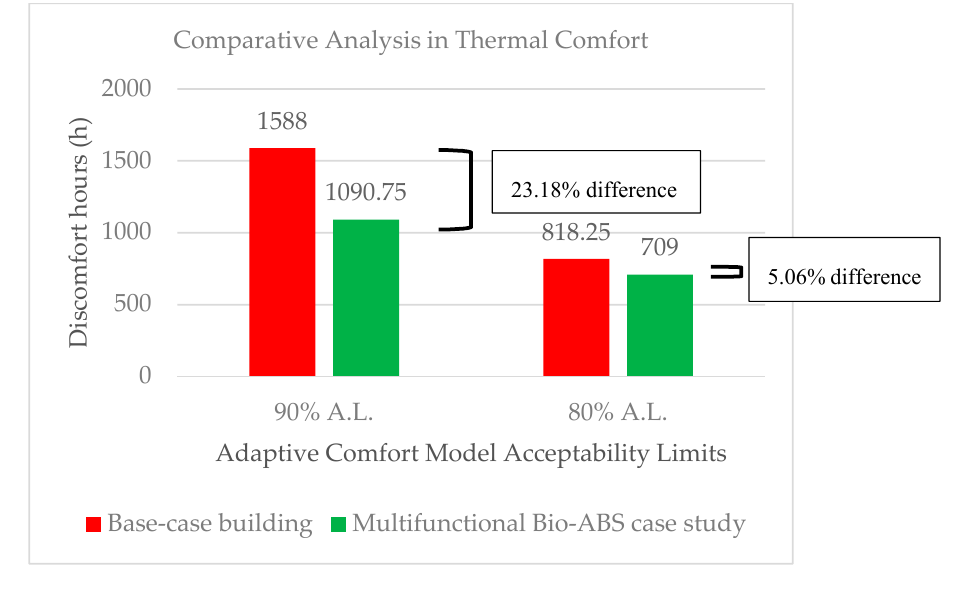
Figure 18. Comparative analysis in thermal comfort between the base-case building and the multifunctional Bio-ABS case study.